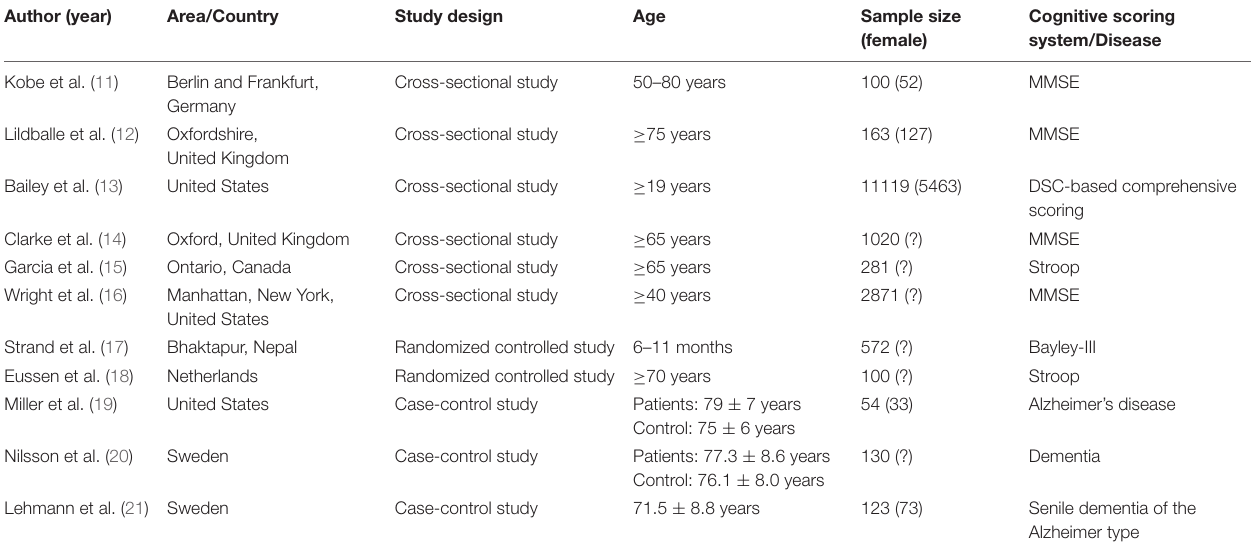
TABLE 2 | General characteristics of the included 11